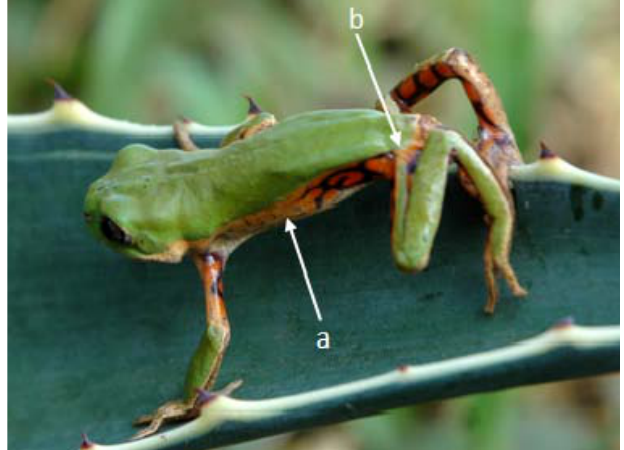
Figure 2. Phyllomedusa azurea collected in the municipality of Água Doce, state of Santa Catarina, Brazil. The arrows indicate characteristics that differ from the original pattern described by Caramaschi (2007 “2006”): (a) the reticulate pattern of flanks and thighs, (b) discontinuity in the green stripe. Photo by Eliara S.